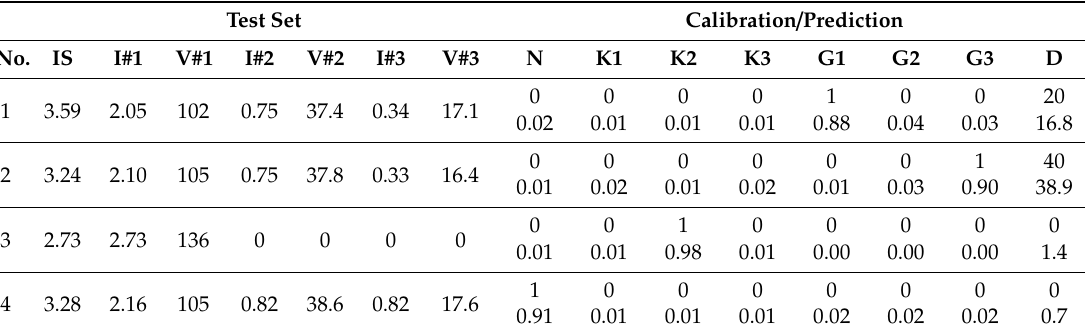
Table 4. Experimental results of fault